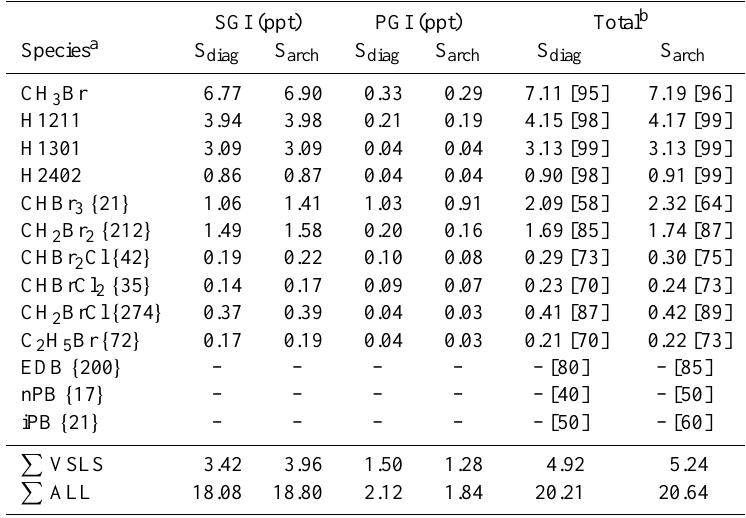
Table 2. 2007 tropical mean source gas injection (SGI), product gas injection (PGI) and total bromine (SGI + PGI) loading from VSLS, CH 3 Br and the halons in the lower stratosphere. Results are from simulations S diagnosed and S archived